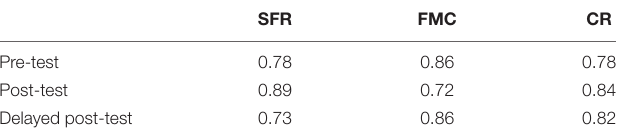
TABLE 3 | Reliability of the vocabulary